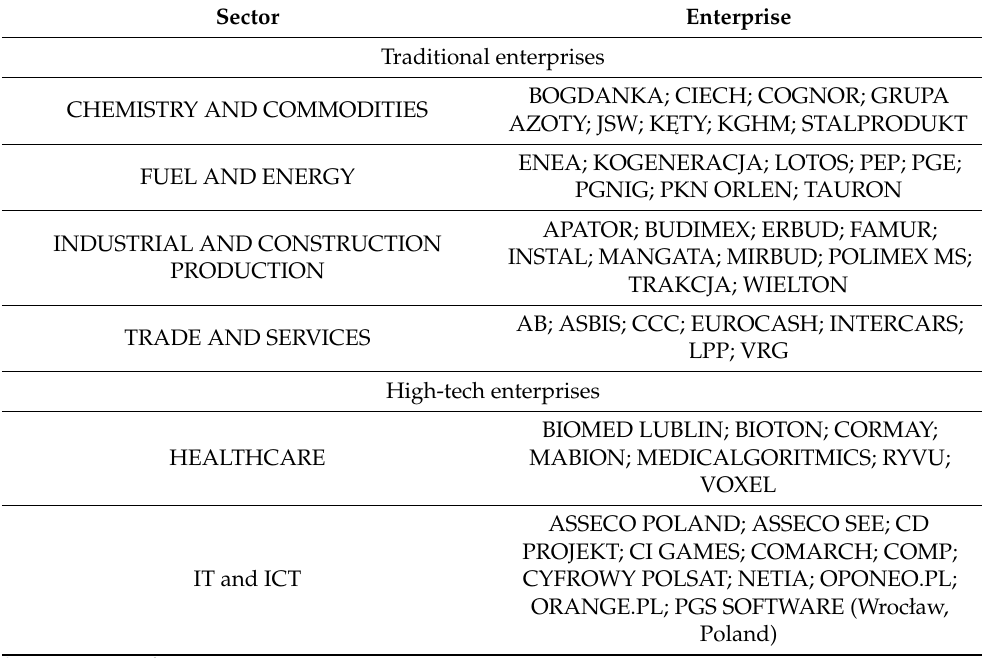
Table 1. List of enterprises included in the